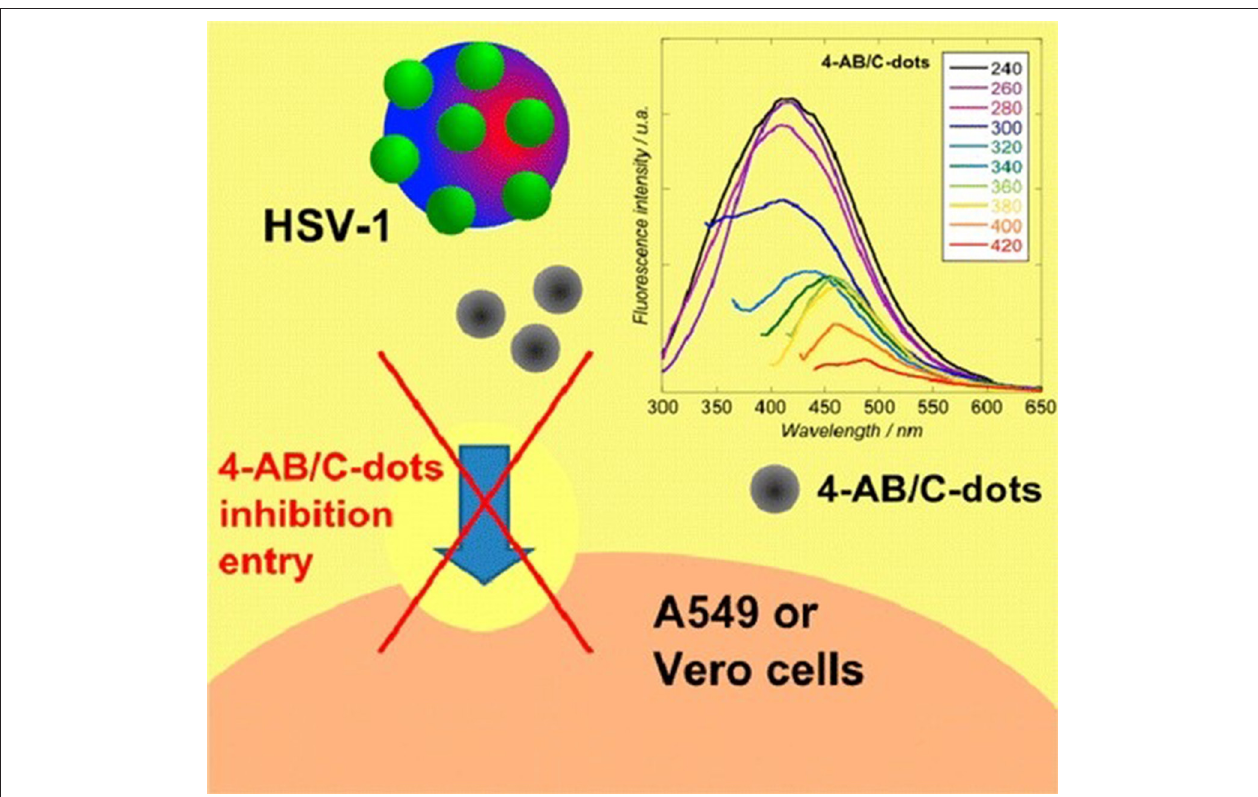
FIGURE 1 | Mechanism of inhibition of entry step by 4-aminophenylboronic acid hydrochloride derived carbon dots. Reprinted with permission from Barras et al. (2016) . Copyright (2016) American Chemical Society.